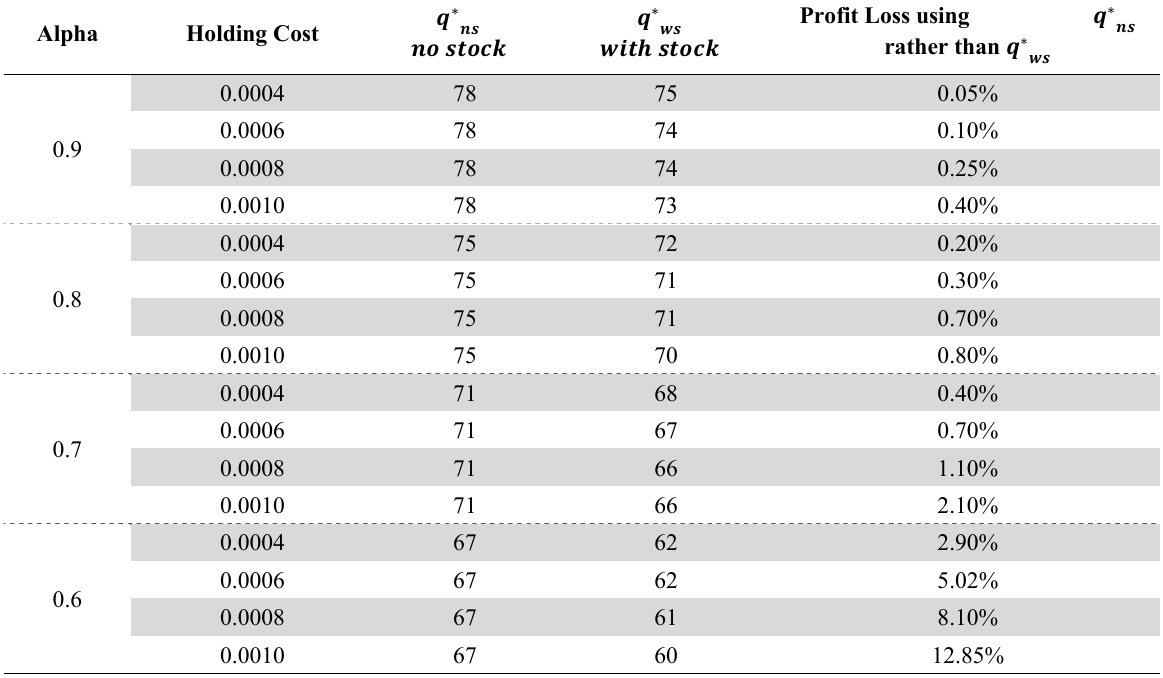
Profit loss neglecting stockholding